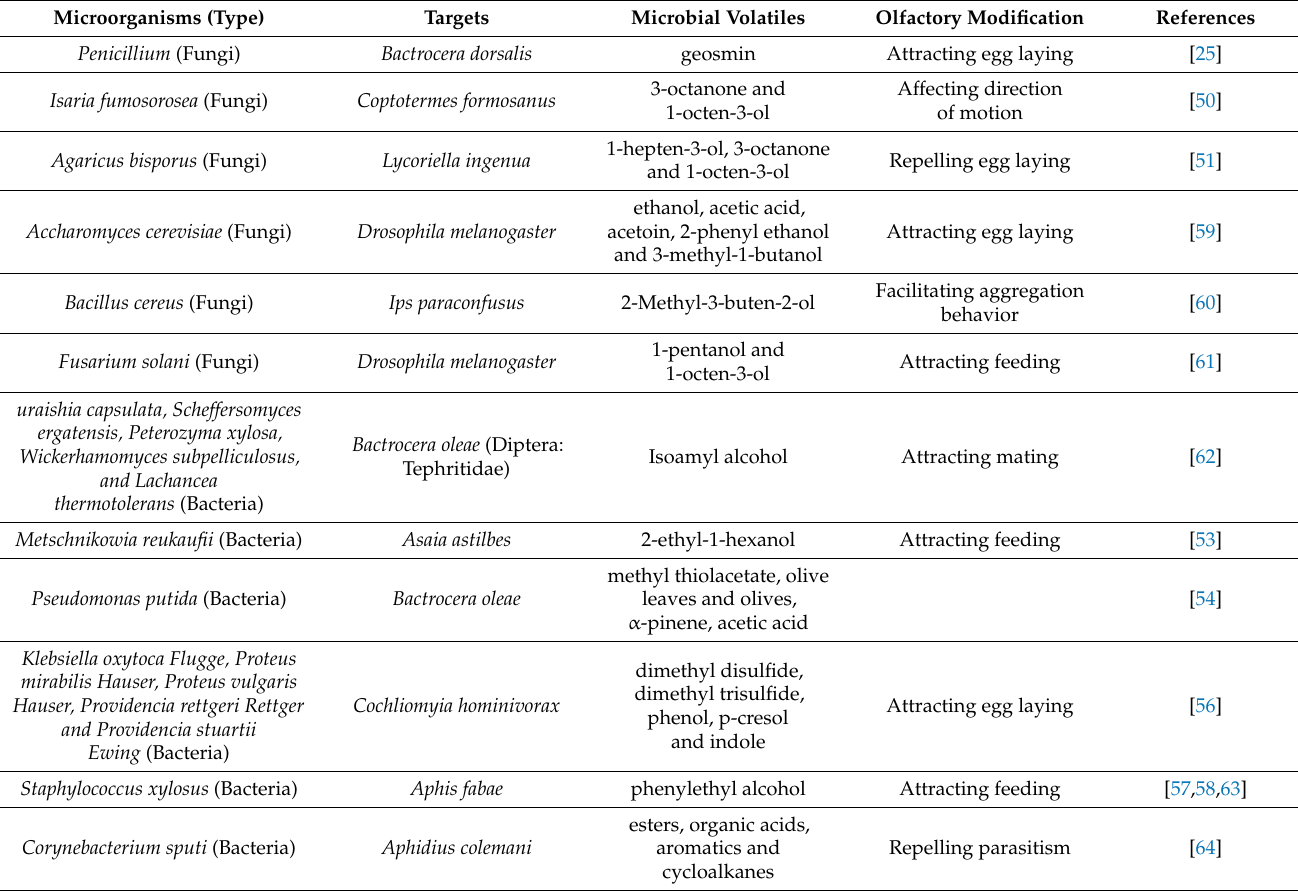
Table 1. Cases of microorganism volatiles trigger changes in insect behaviors through olfactory cues.